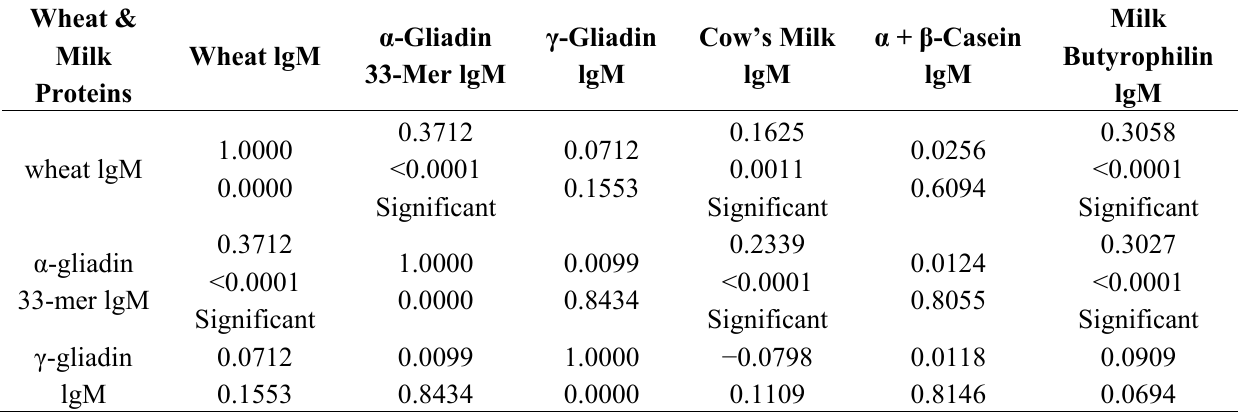
Table 6. Results of the simple linear regression between each pair of lgM isotype of the antigens. The first number in each cell presents corresponding Pearson’s correlation coefficient and the second number presents its p -value. Small p -value (less than 0.05) indicates statistical significance. Note that R 2 values of these regressions are the squares of the Pearson’s correlation